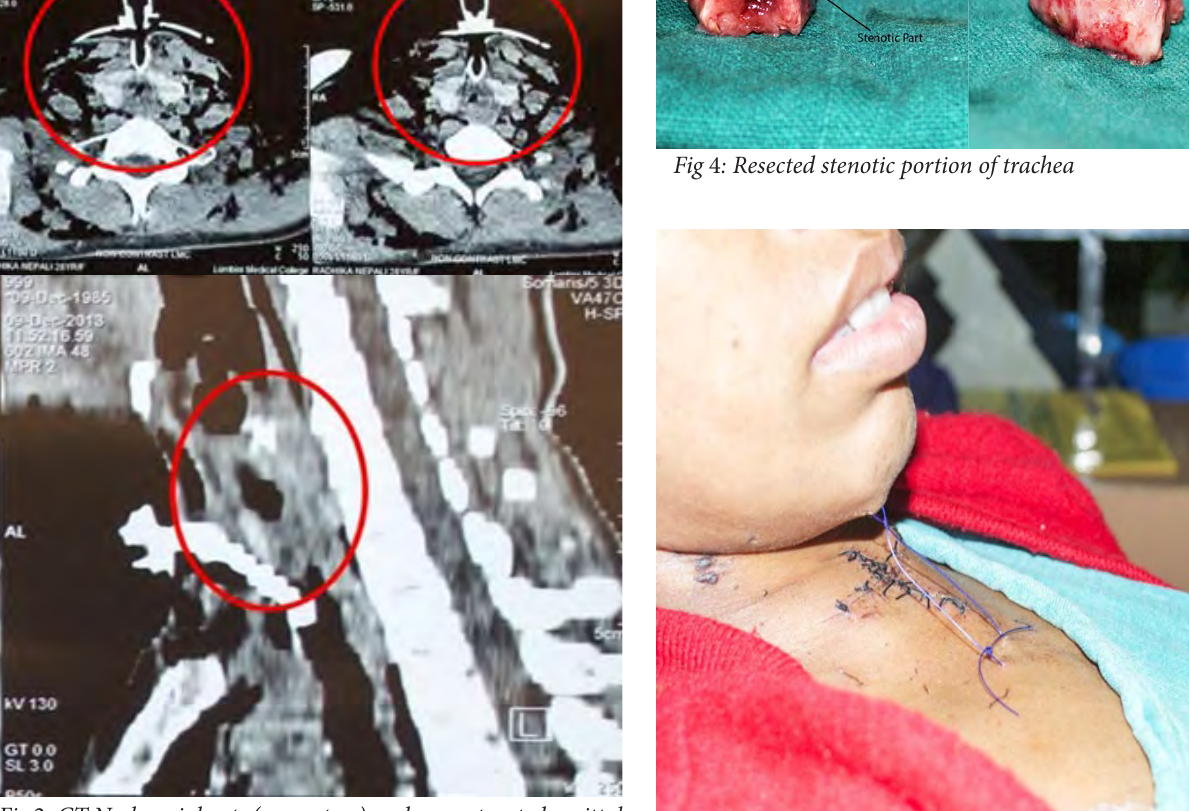
Fig 2 : CT Neck, axial cuts (upper two) and reconstructed sagittal (lower) shows tracheal stenosis just above tracheostomy tube.